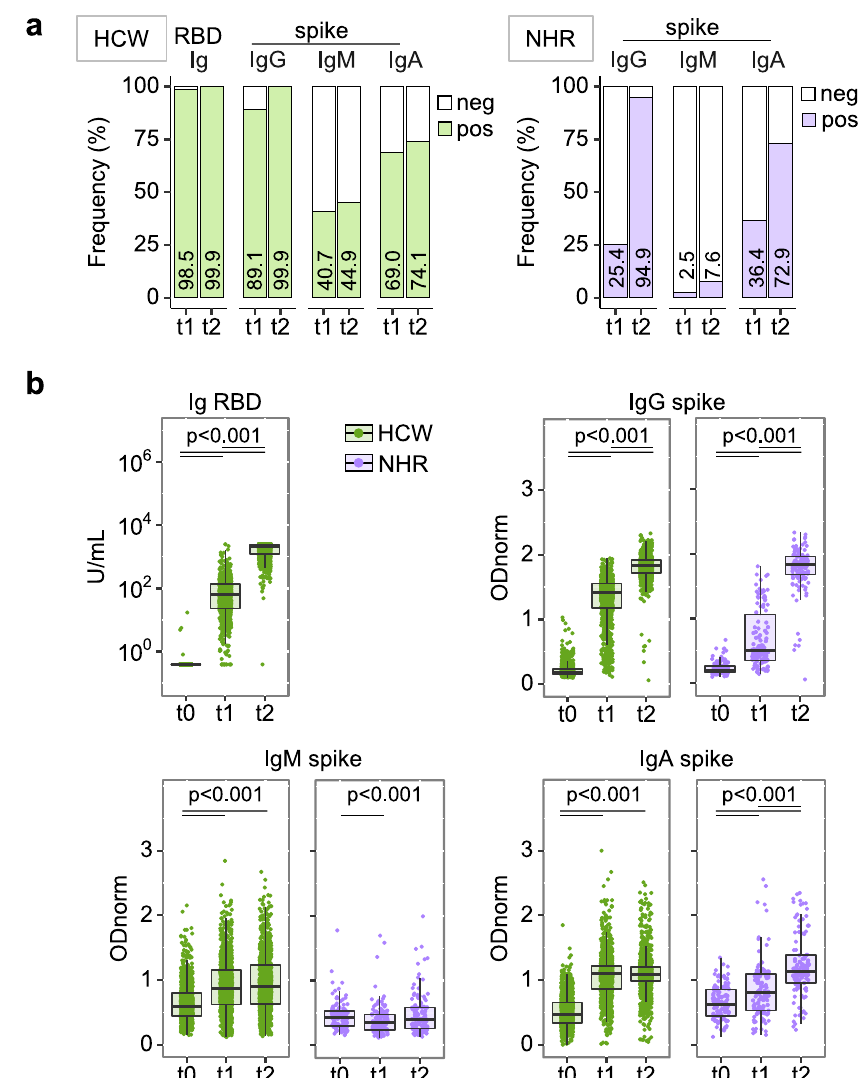
Fig. 2 Heterogenous anti-SARS-CoV-2-spike reactivities induced by vaccination. Sera collected as in Fig. 1c were analysed for anti-RBD Ig (ECLIA) and anti-full-length spike protein IgG, IgM, and IgA (ELISA). Individuals positive for reactivities against SARS-CoV-2 N antigen were removed from the dataset. Health Care Workers (HCW) n = 948, in green, and Nursing Home Residents (NHR) n = 118, in purple. a Seroconversion de fi ned by frequency of samples testing positive (colored bars) at the indicated day and assays. Respective values are indicated inside each bar. b Semi-quantitative measurements. Data points represent individual participants, boxes denote interquartile range, horizontal line represent the median, and whiskers denote the minimum and maximum values below or above the median at 1.5 times the interquartile range. Note the y scale differs for the anti-RBD ECLIA and the anti-spike ELISA data. Index ≥ 0.8 and ODnorm ≥ 1 de fi ne positivity in ( a ). Quade test for group difference across time points, p < 2.2 × 10 − 16 for all panels except NHR IgM where p = 0.001096. Pairwise Wilcoxon signed-rank test over time, two-sided, with p -value adjustment (Benjamini – Hochberg method). HCW: for anti- RBD Ig and anti-spike p < 2.2 × 10 − 16 (t0/t1, t0/t2, t1/t2) ; for anti-spike IgM p < 2.2 × 10 − 16 (t0/t1, t0/t2) and p = 0.4 (t1/t2) ; for anti-spike IgA